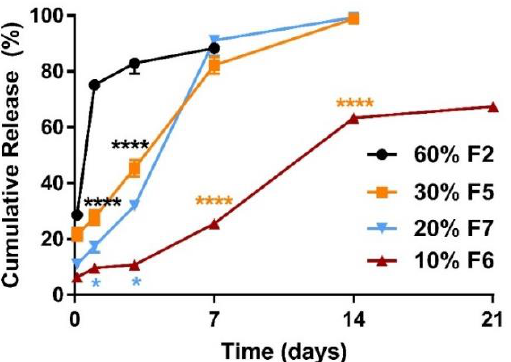
Figure 1 . Mean (±SEM) in vitro ketamine percentage of cumulative release in 24 h for a range of formulations ( n = 3). Reducing the ketamine payload from 60% to 30% and from 30% to 10–20% reduced the burst effect (****, P < 0.0001). One-way ANOVA followed by the Bonferroni test.